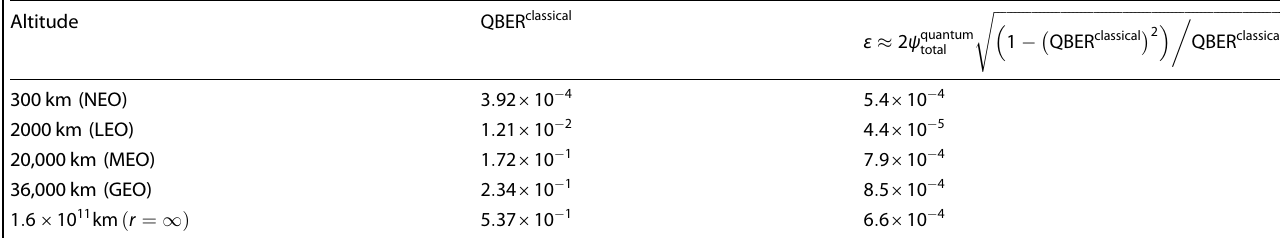
Table 2. Total QBER and the fractional change ε induced by quantum WRA for the spiraling Earth Orbit: QBER classical ¼ sin 2 ψ classical QBER classical þ quantum ¼ sin 2 ψ total